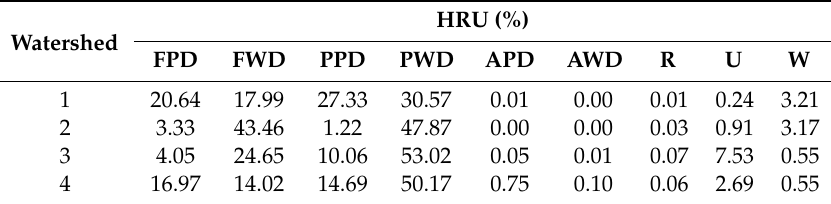
Table 2. Percentages of HRU in each